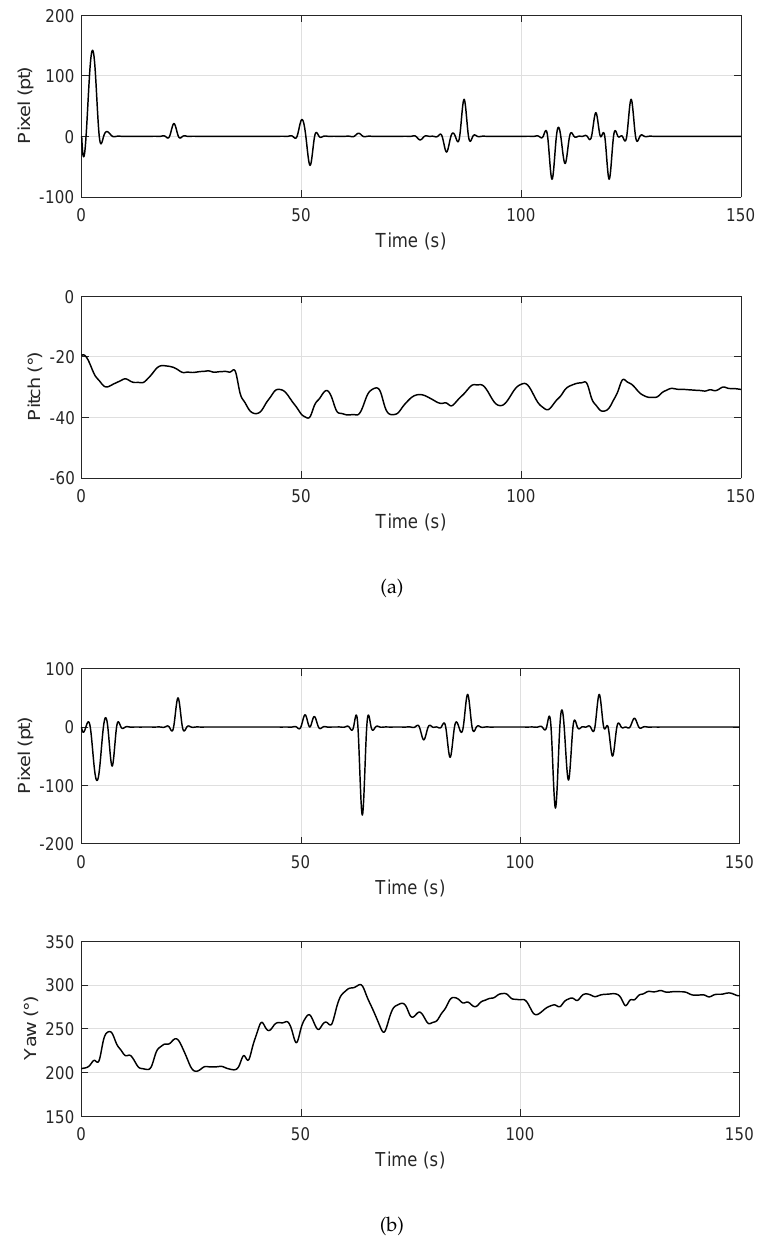
Figure 13. Rotation angles’ diagram: ( a ) Y-axis offset error and PTZ pitch angle; ( b ) X-axis offset error and PTZ yaw